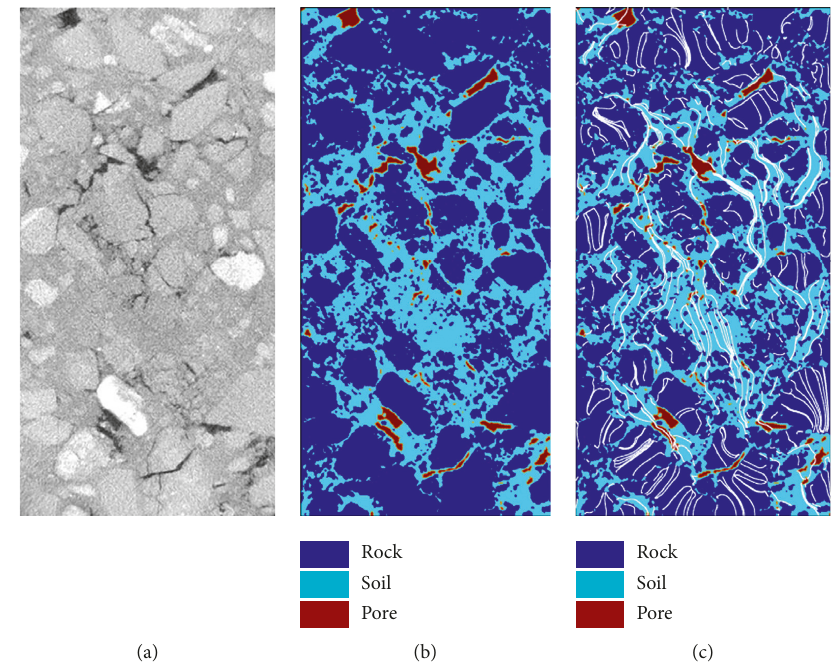
Figure 5: CT image cumulative greyscale value frequency statistics.